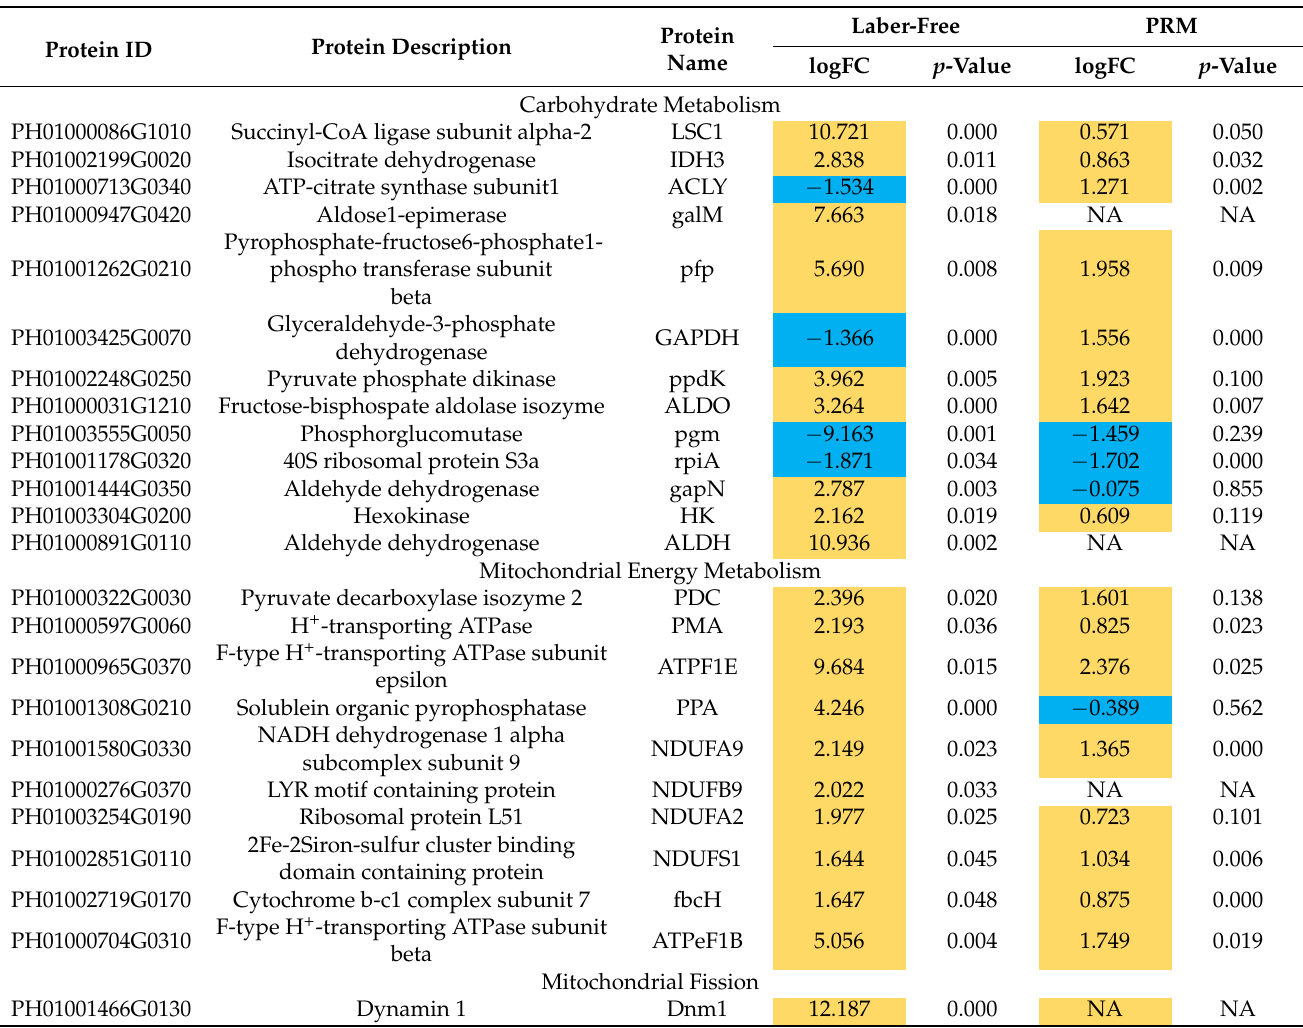
Yellow indicates upregulated genes and proteins, and blue indicates downregulated genes and proteins in spring shoot stage. NA indicated that PRM detection was not performed. Significant difference: p <